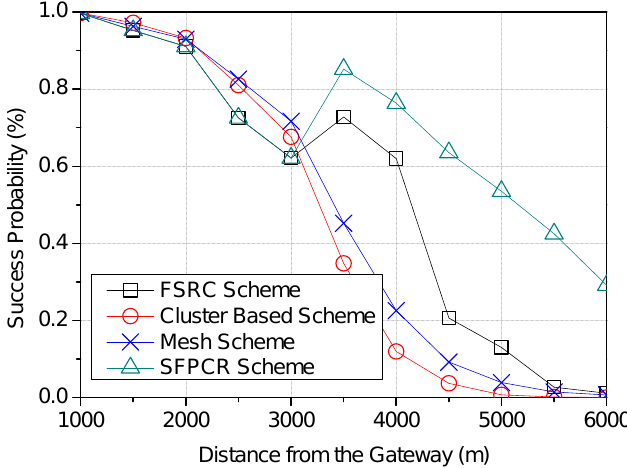
Figure 7. Plots variation in Success Probability according to the Distance of LoRa devices from the GW with a comparison between the SFPCR scheme and other